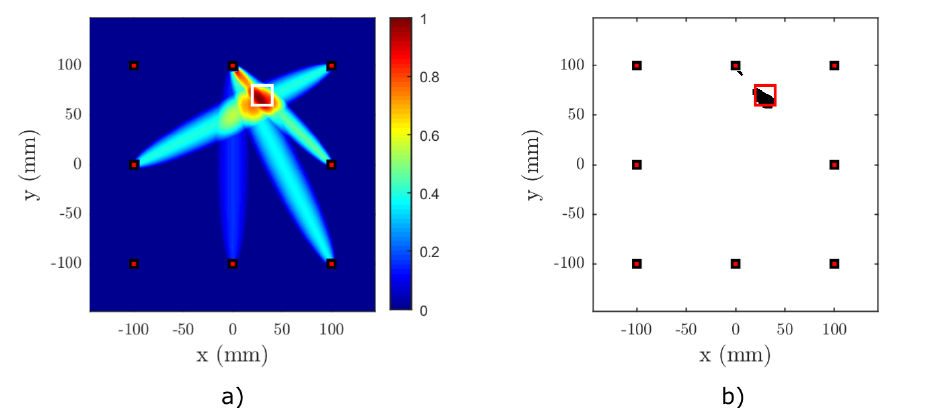
Figure 7. Result of Test Case 2 for nonlinear RAPID imaging on a simulated anisotropic plate, ( a ) without binarization and ( b ) with binary thresholding. The center of the delamination is located at [30, − 70]. The binarization threshold was set to t P = 0.8, the shape factor to β = 1.015 and the SDC threshold to t SDC = 0.25. The actual location of the delamination is marked with a white square in (a) and a red square in